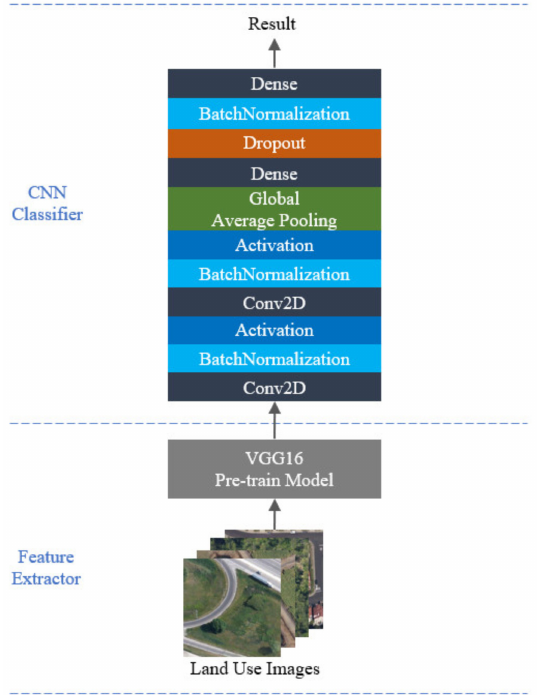
Figure 9. RSSCNet classifier network